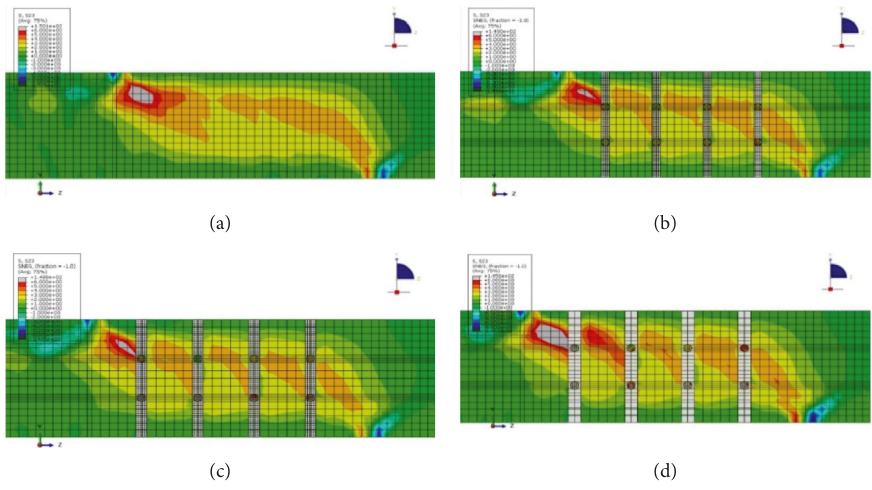
Figure 6: Numerical failure mode of beams (a) CB, (b) BSC20, (c) BSC25, and (d)